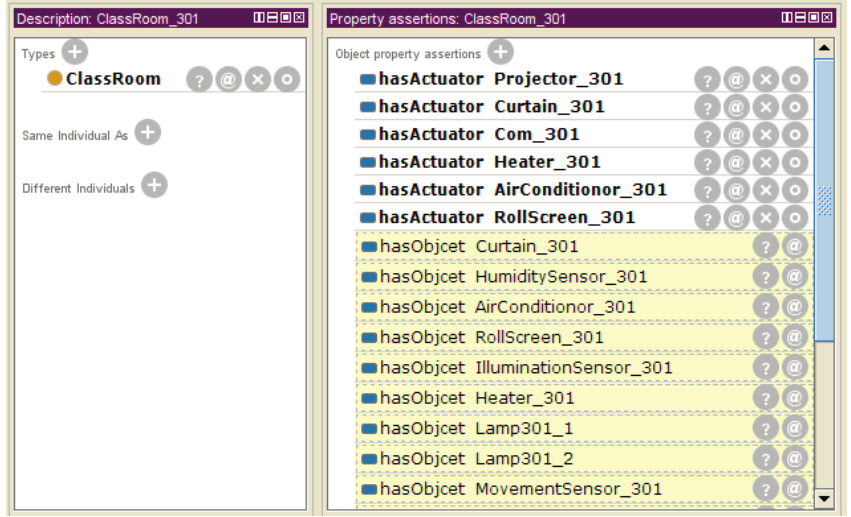
Figure 17. Object instance example in ClassRoom_301